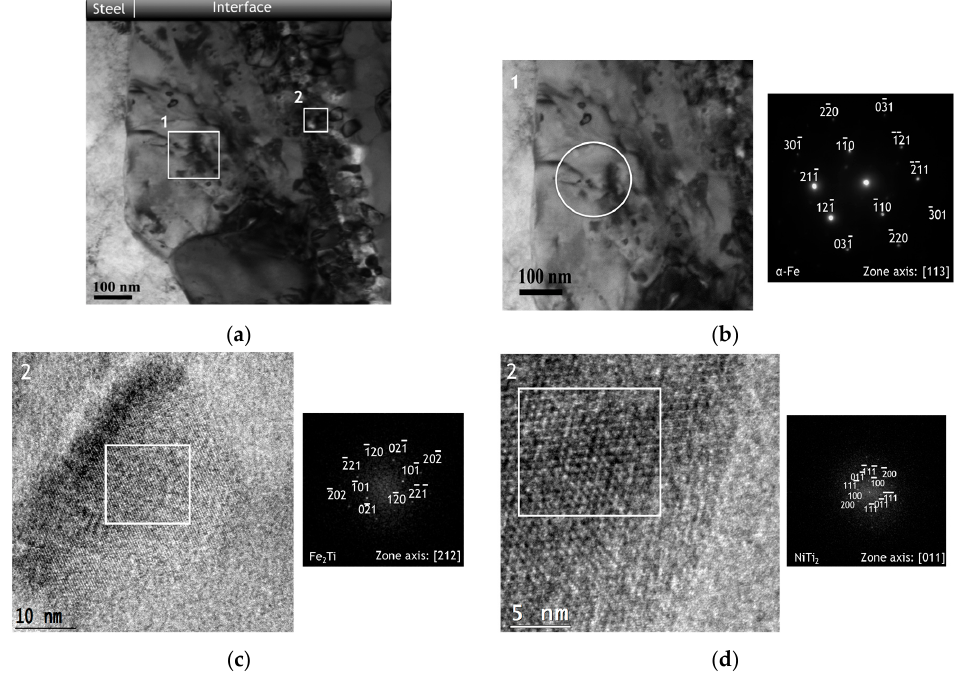
Figure 5. ( a ) TEM image of the zone close to the steel; ( b ) TEM images and SAED indexation as α -Fe of a grain at the region marked as 1 in ( a ); and ( c ) HRTEM images and FFT indexation as Fe 2 Ti of a grain at the region marked as 2 in ( a